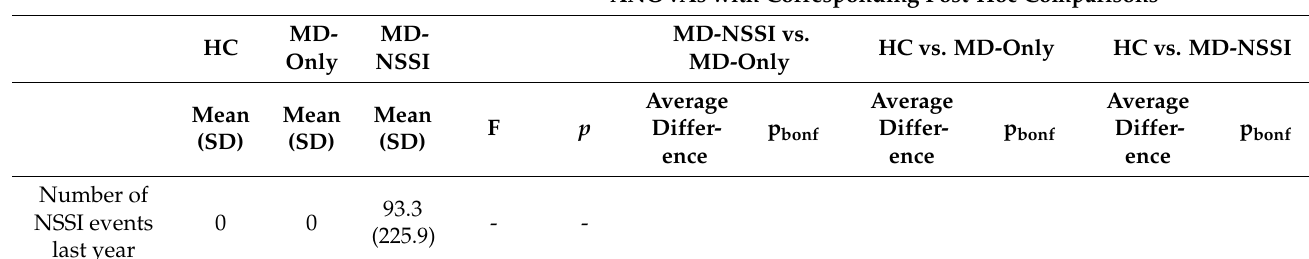
Table 1. Cont. ANOVAs with Corresponding Post-Hoc